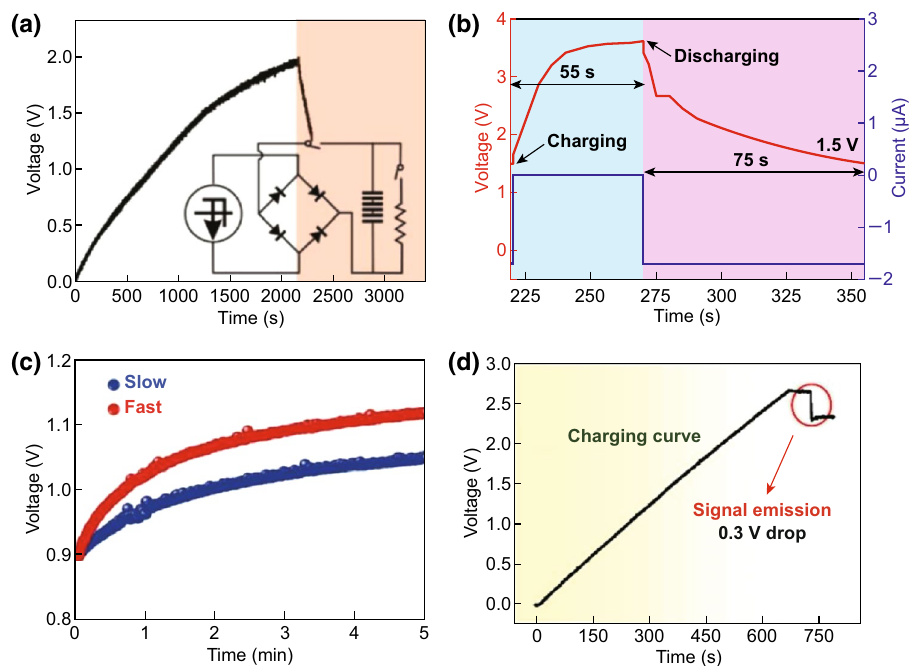
Fig. 12 a V – t curve of the 3‑series EP‑SCs charged by pressing 3‑parallel EP‑TENGs. Reprinted with permission from Ref. [24]. b Charging and discharging curves using the TENG at wind speed of 24.6 m s −1 . Reprinted with permission from Ref. [25]. c Charging curves of another convoluted power device as an SLB using the produced electric energy by human walking. Reprinted with permission from Ref. [27]. d V – t curve of the PC‑SCPU under charging mode and then instantaneously driving a wireless remote control. Reprinted with permission from Ref.